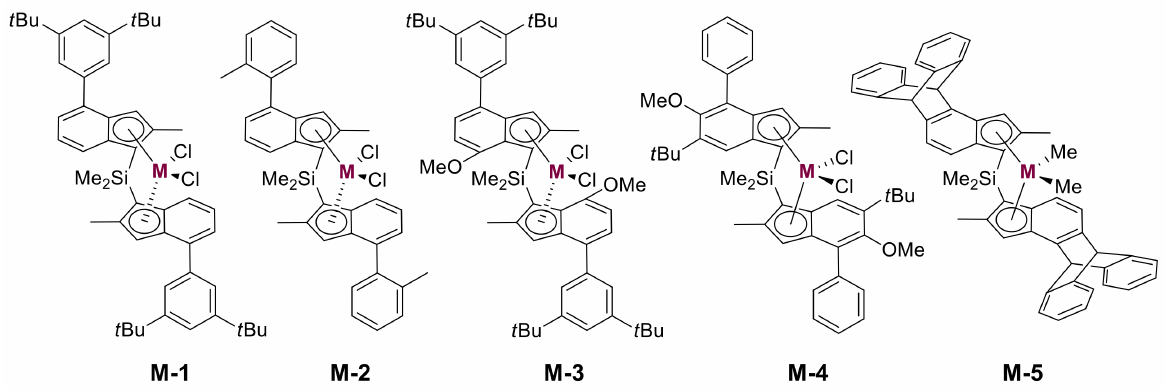
Figure 1. Precatalyst pairs M-1 to M-5 (M = Zr or Hf) screened in propene polymerization at T p = 60 and 100 ◦